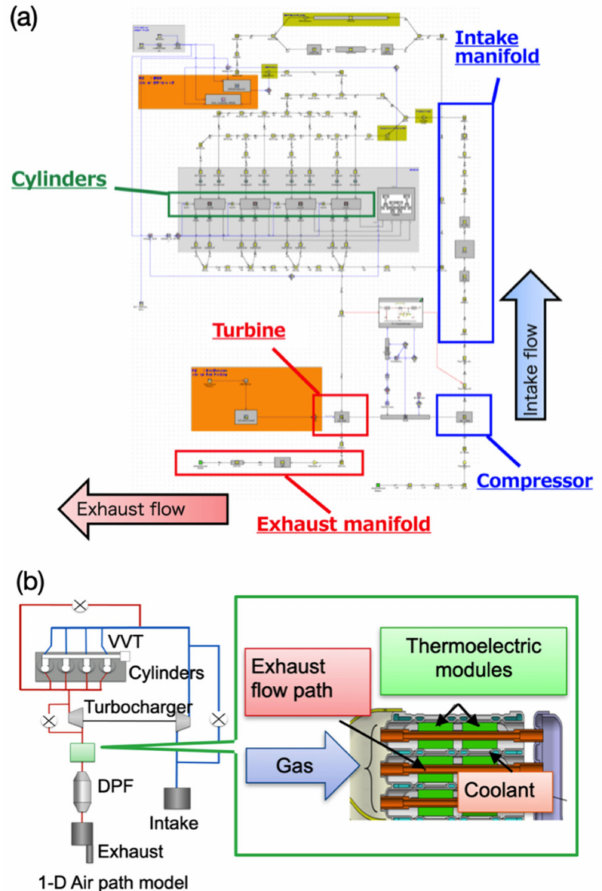
Figure 9. ( a ) Engine model in GT-POWER and ( b ) schematic configuration of the waste heat power generation unit in a combustion engine exhaust